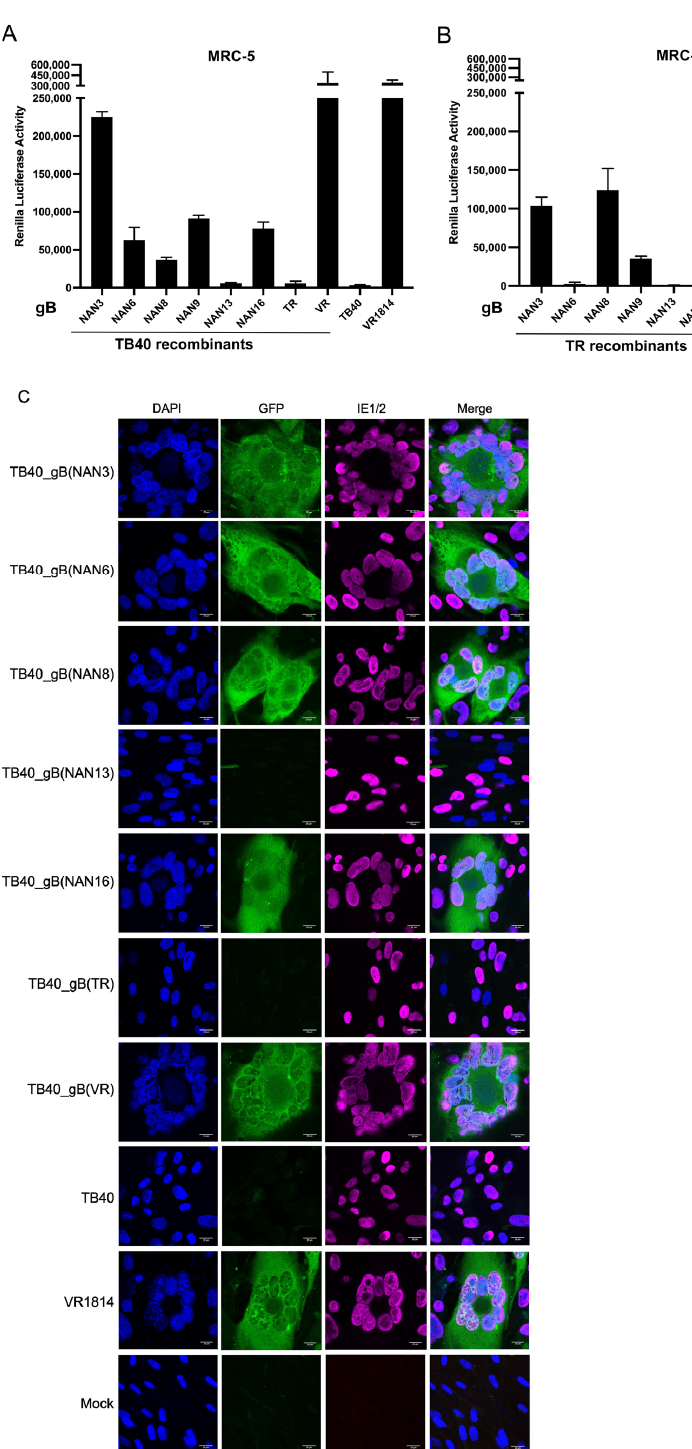
Figure 4. HCMV-induced cell–cell fusion of MRC-5 fibroblasts. Cells expressing the DSP system were infected at an MOI of 1. Cell–cell fusion was detected 3 days post-infection by measuring Renilla luciferase activity ( A , B ) or by the detection of GFP fluorescence ( C ). The bar diagrams show means ± SD of three biological replicates. Scale bar, 20 μ m.